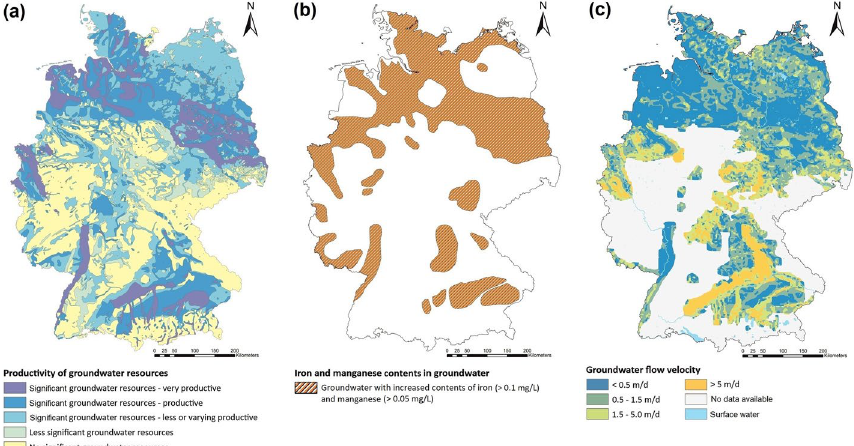
Fig. 2 Hydrogeological criteria of the ATES potential study for Germany: a aquifer productivity (BGR 2019a), b iron and manganese contents in groundwater (BGR 2019b), c mean groundwater distance velocity (Wendland et al.